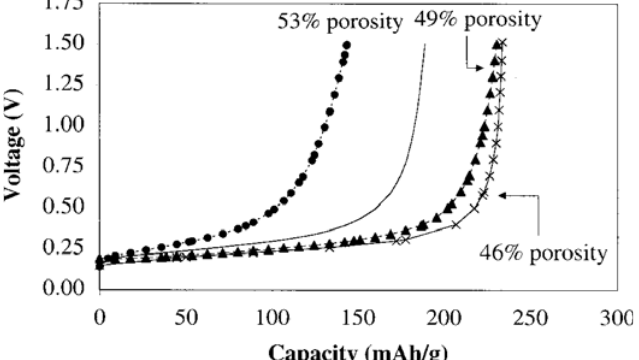
Figure 6. Effect of anode porosity on charge capacity for prismatic cell and cylindrical cell charge at 1C at 300 cycles